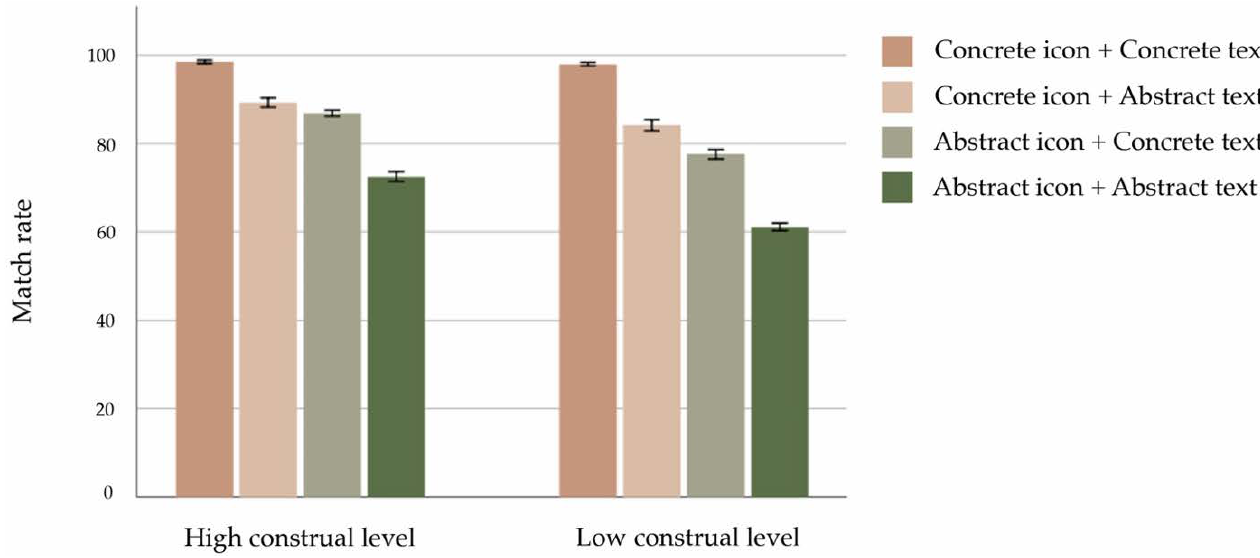
Figure 5. Match rate for four types of combination design icons in two groups of users with different construal levels.